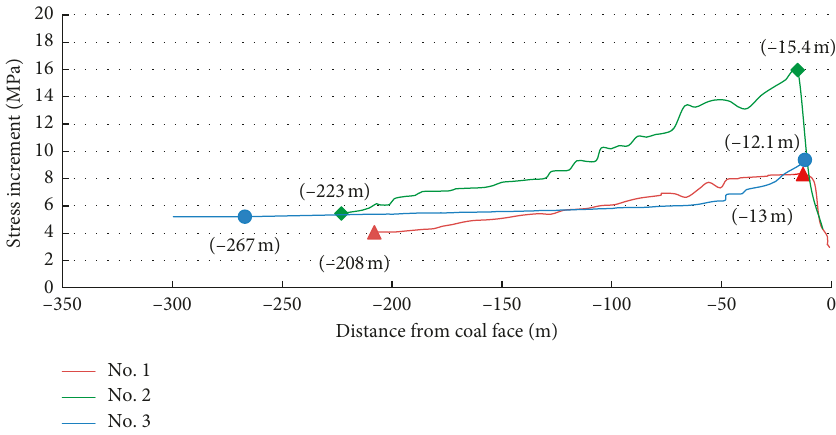
Figure 10: Variation curves of vertical stress